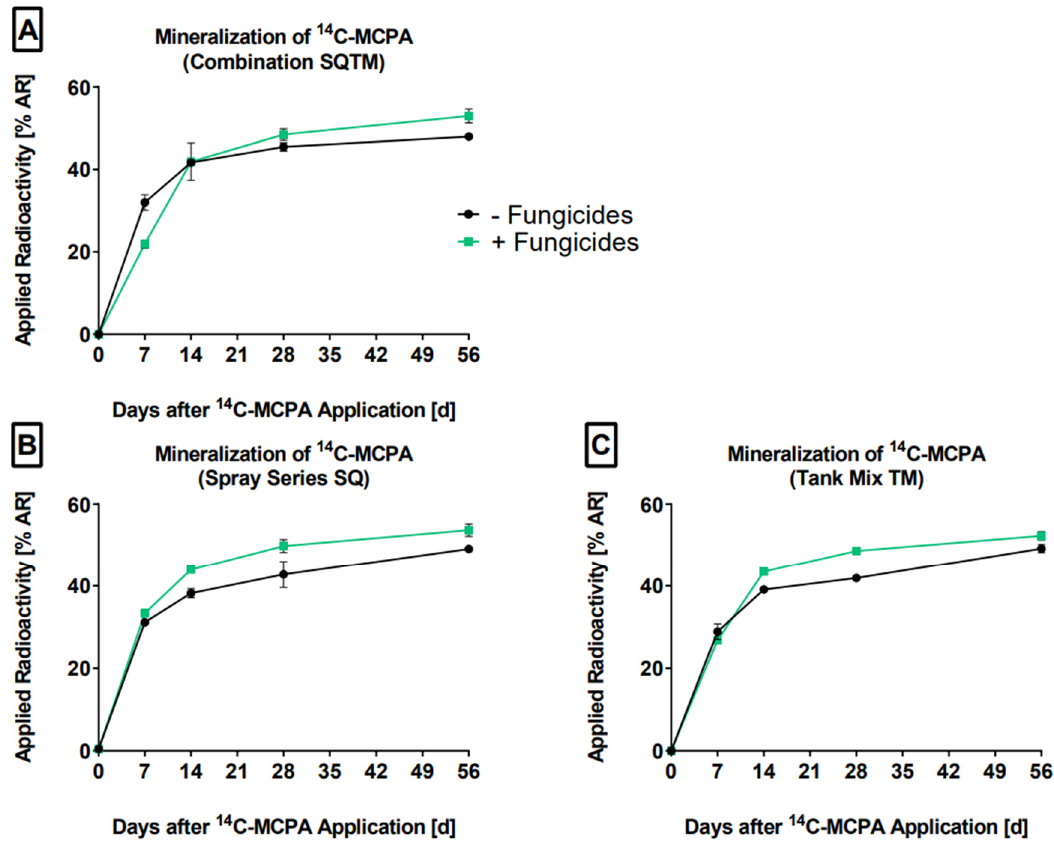
Figure 2. The mineralization (% AR) of MCPA in the absence (-F, black line) and presence (+F, green line) of the fungicides on days 0, 7, 14, 28, and 56 are presented. ( A ) SQTM-F: control, SQTM+F: combination ( B ) SQ-F: control, SQ+F: spray series, and ( C ) TM-F: control, TM+F: tank mix. The mean values and standard deviations were derived from triplicates (n = 3).